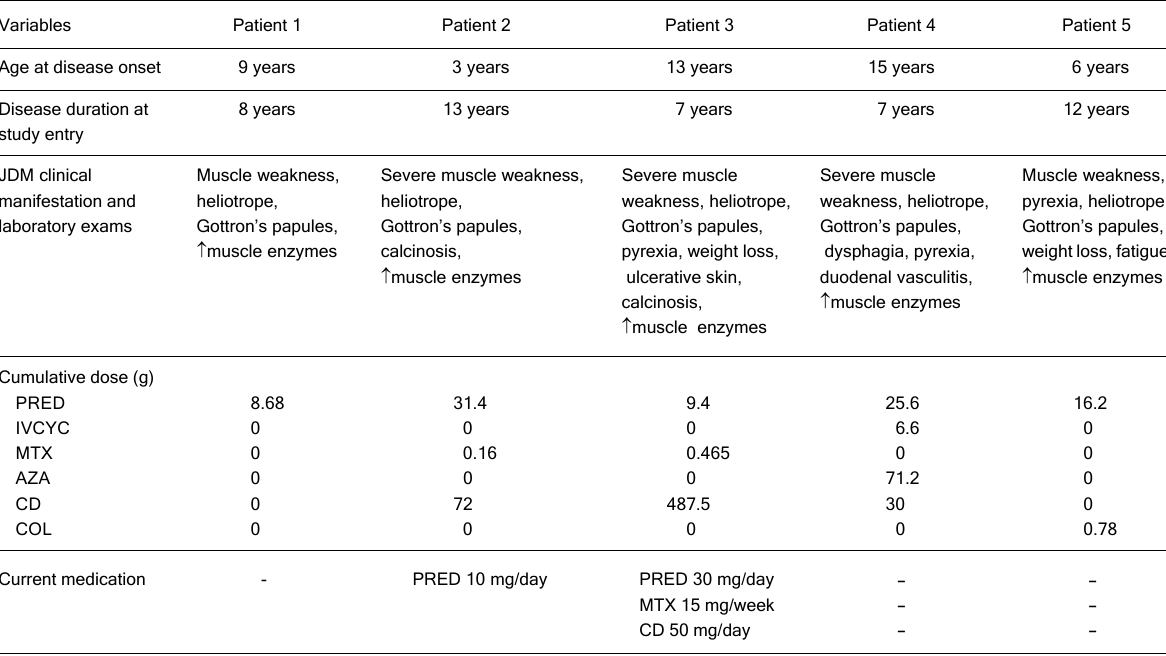
Table 1. Demographic data, clinical features, laboratory exams, previous and current therapy in 5 male juvenile dermatomyositis